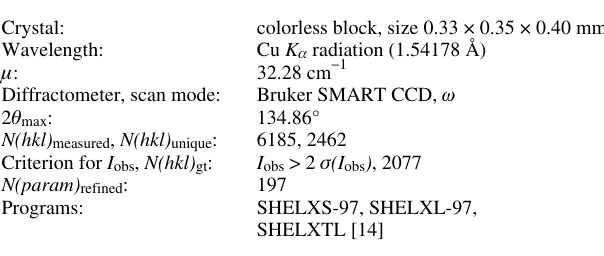
Table 1. Data collection and handling.